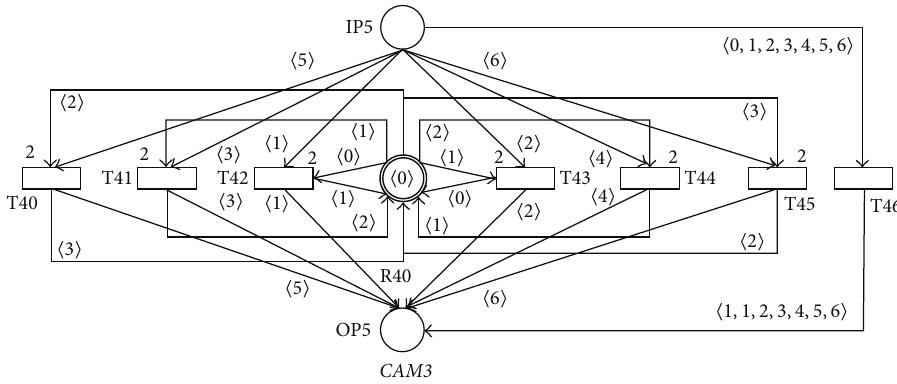
Figure 18: SNT process net